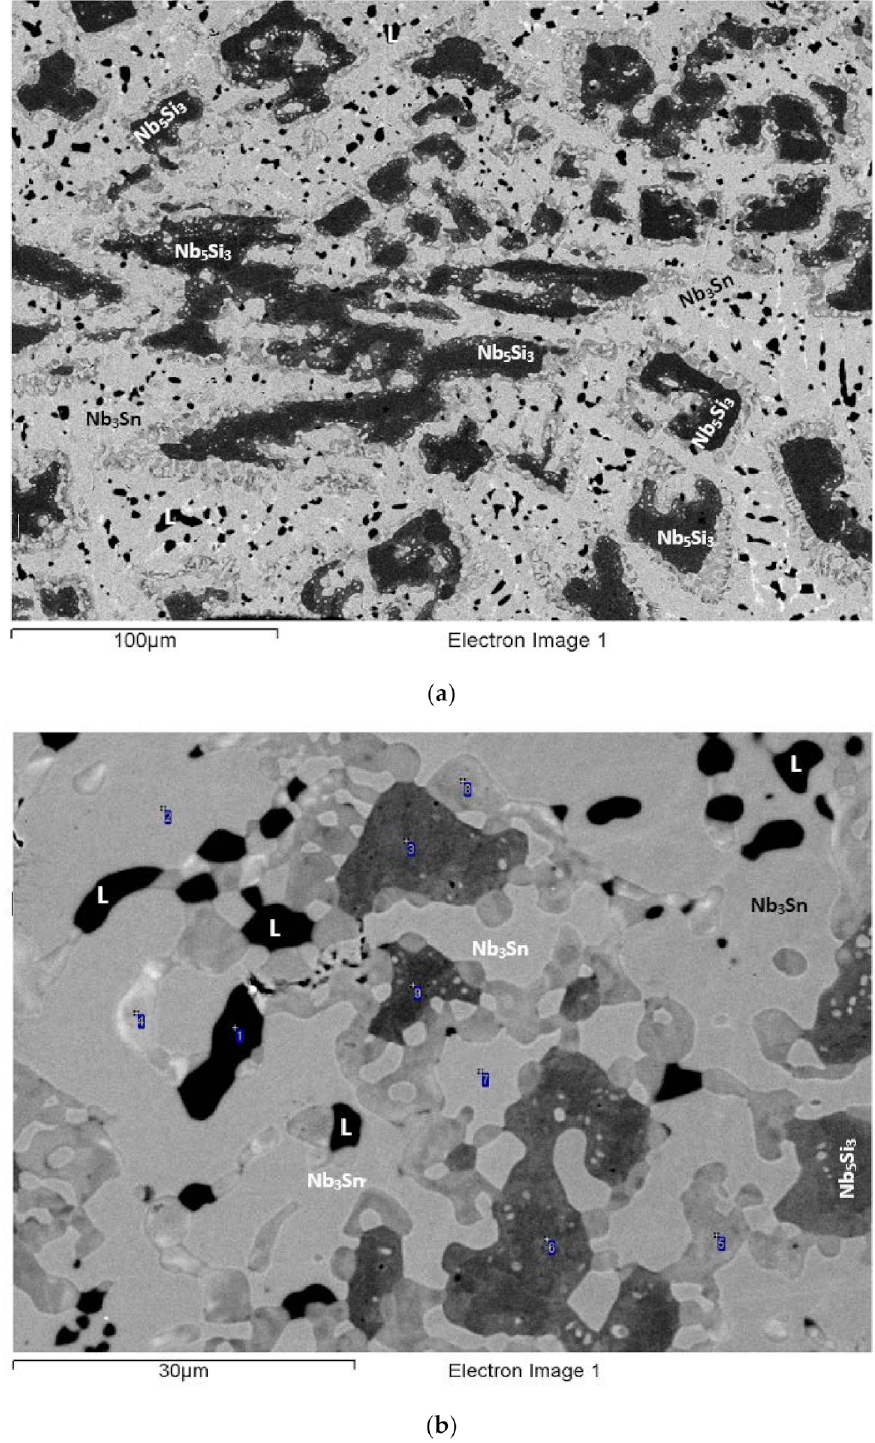
Figure 11. BSE images of the microstructure of EZ8-HT. In ( a , b ) the Laves phase is indicated with L. The A15-Nb 3 X is shown as Nb 3 Sn. In ( b ) the Laves phases is shown with the number 1, the Nb 3 Sn with 2, 7, the Nb 5 Si 3 with 3, 6, 9, the Hf-rich Nb 5 Si 3 with 4, 5, 8. The brighter contrast areas to the left of number 4 are Hf-rich Nb 5 Si 3 with Nb/(Ti + Hf) =